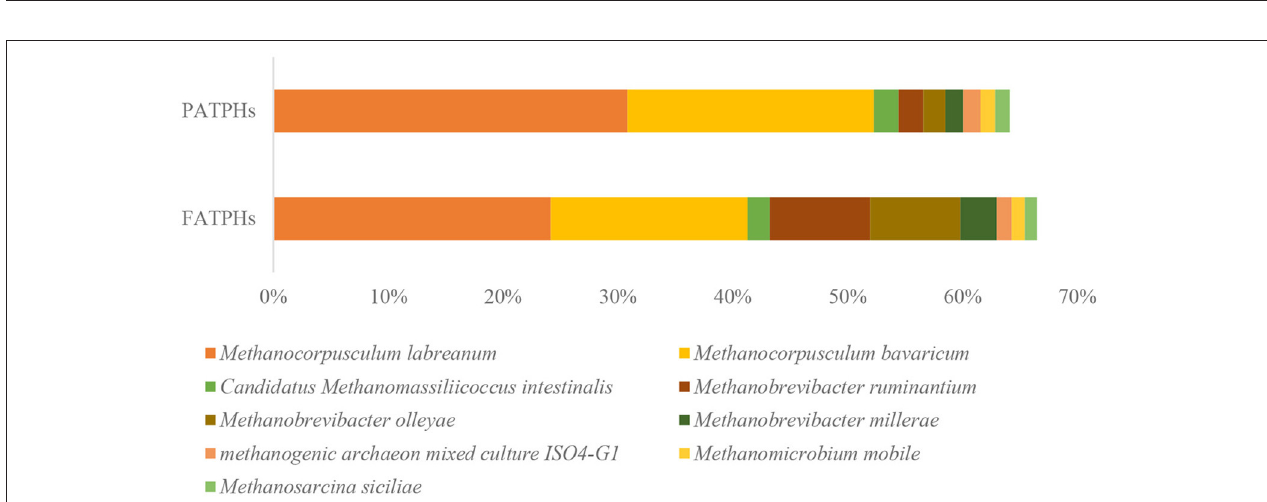
FIGURE 1 | Relative abundances of archaea genera ranked by one and zero orders of magnitude in PATPHs shown together with relative abundances of the corresponding genera in FATPHs.